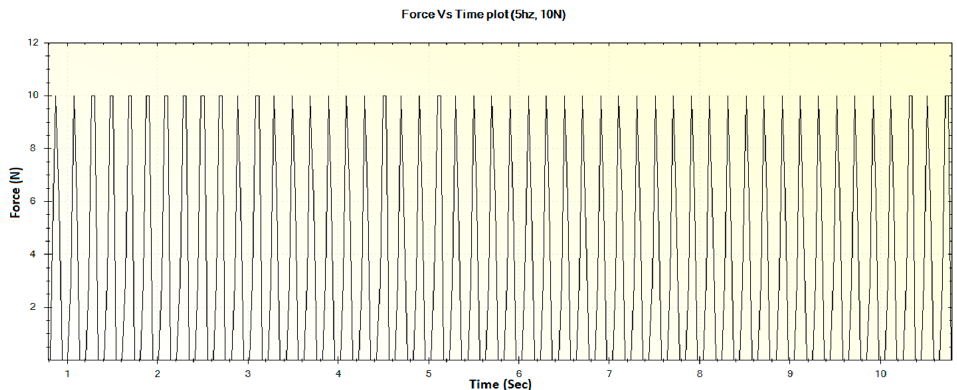
Figure 21. Generated waveform for 5 Hz operation producing a force of 10 N.